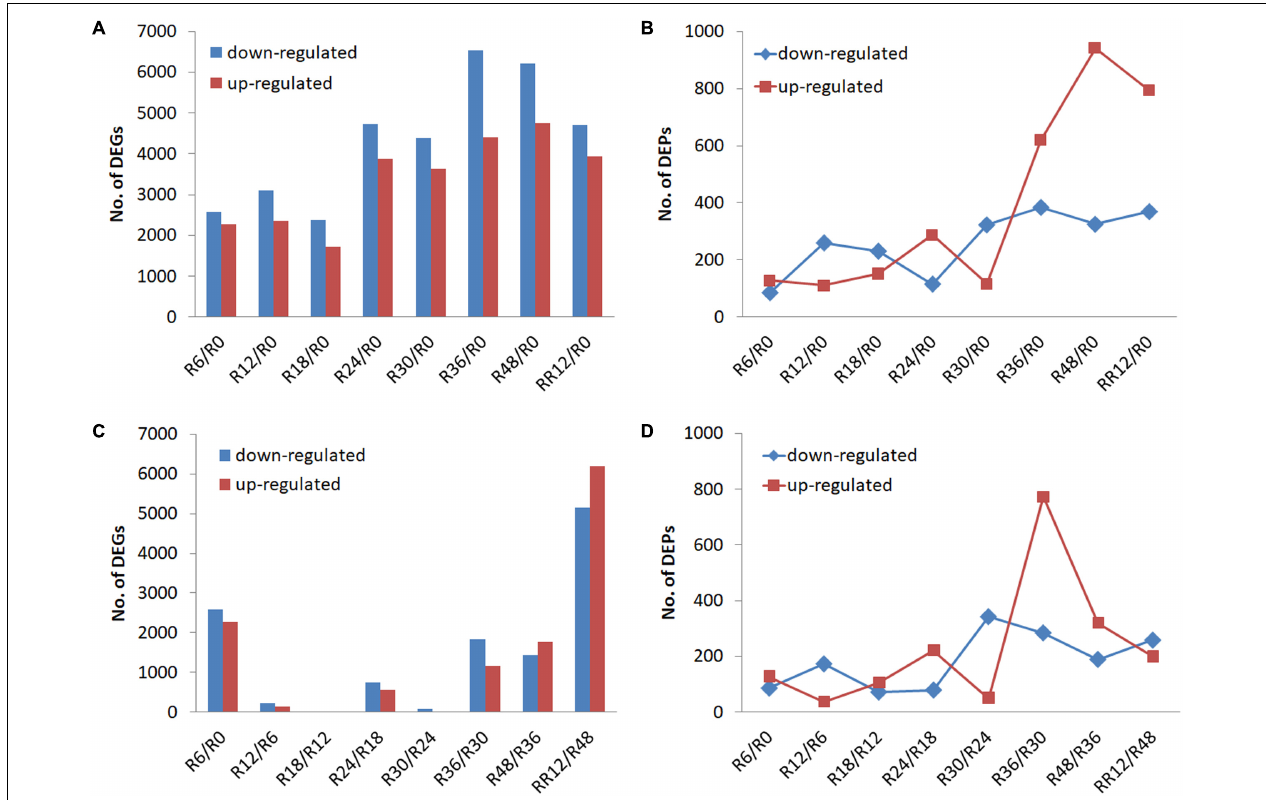
FIGURE 1 | Transcriptome and proteome profiling of M. laxiflora at different time-points during flooding and post-flooding recovery treatment. (A,B) Up-regulated and down-regulated DEGs and DEPs, respectively, identified for a certain period of flooding compared with the control (R0). (C,D) Up-regulated and down-regulated DEGs and DEPs, respectively, identified between a time point and the preceding time point. R0, R6, R12, R18, R24, R30, R36, and R48 represent the samples collected at 0, 6, 12, 18, 24, 30, 36, and 48 h after the flooding treatment, respectively, while RR12 indicates the samples collected at 12 h after post-flooding recovery